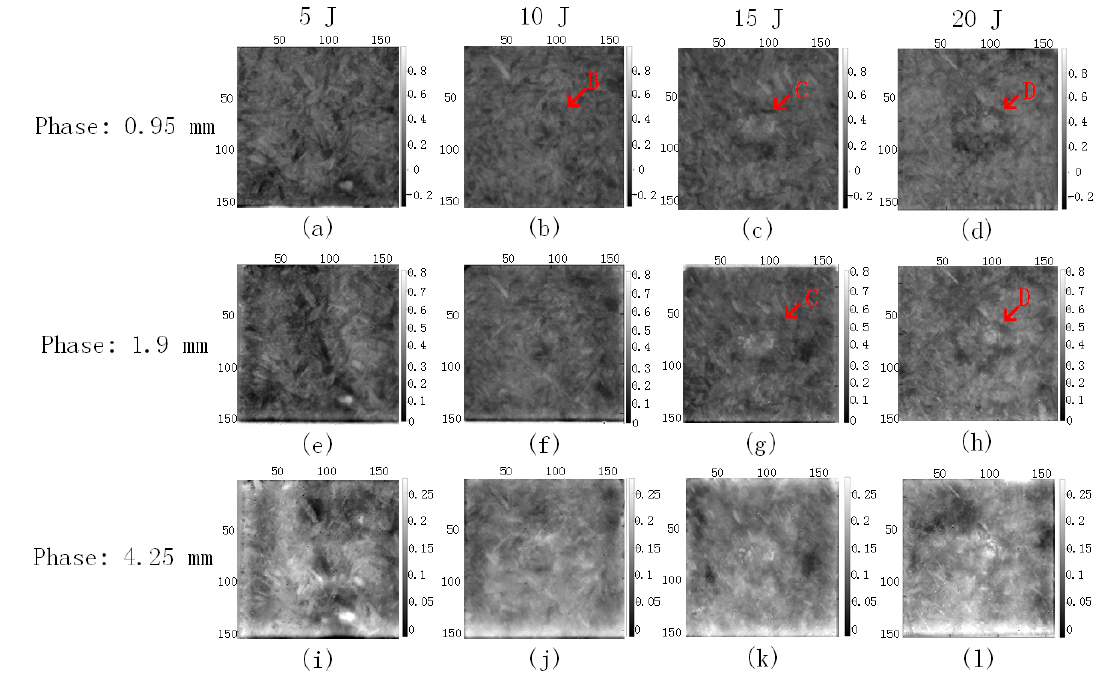
Figure 14. Phase-based LT for the SCB